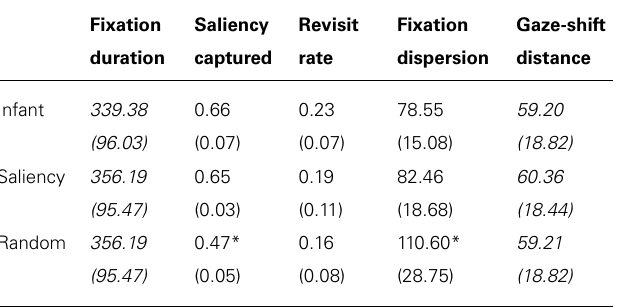
Table 1 | Summary statistics as a function of observer